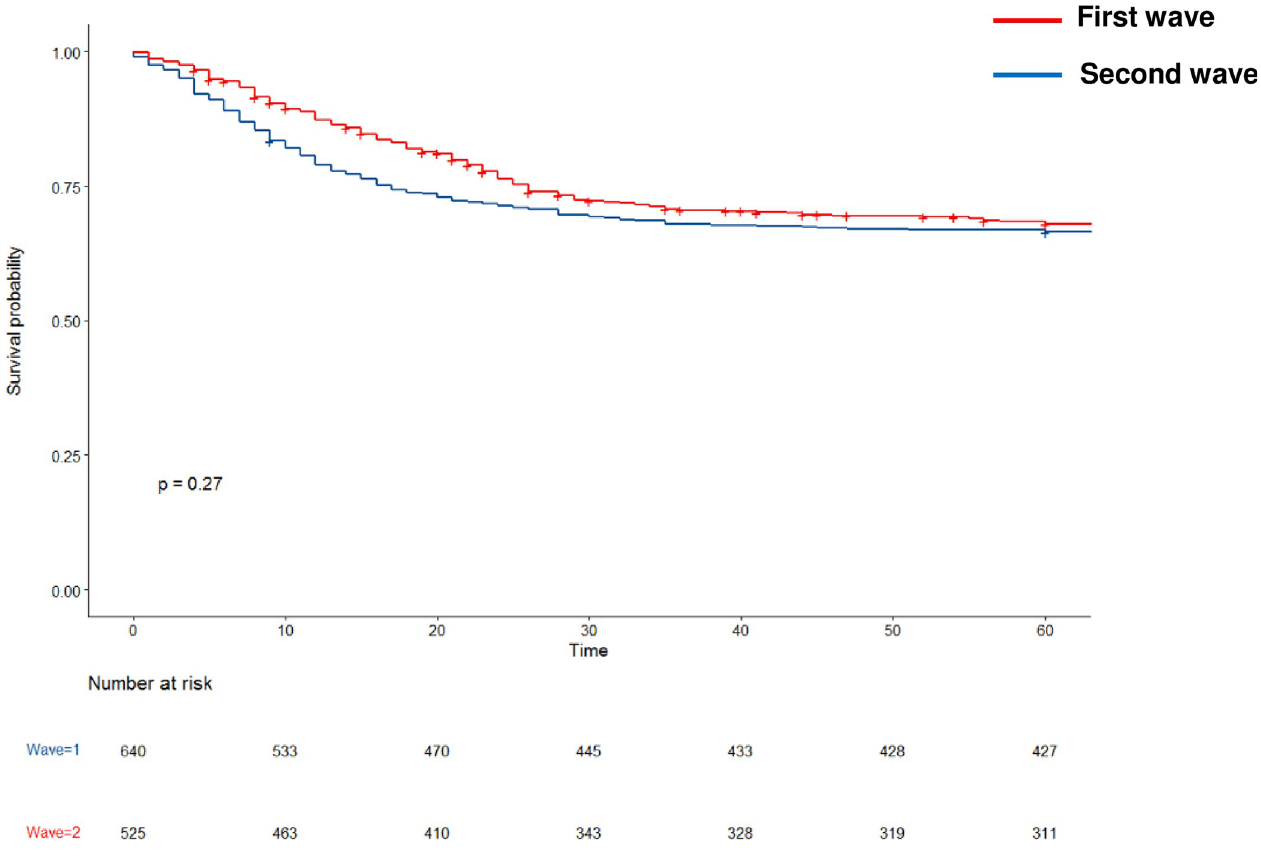
Fig 2. Cumulative incidence of death during the first and the second